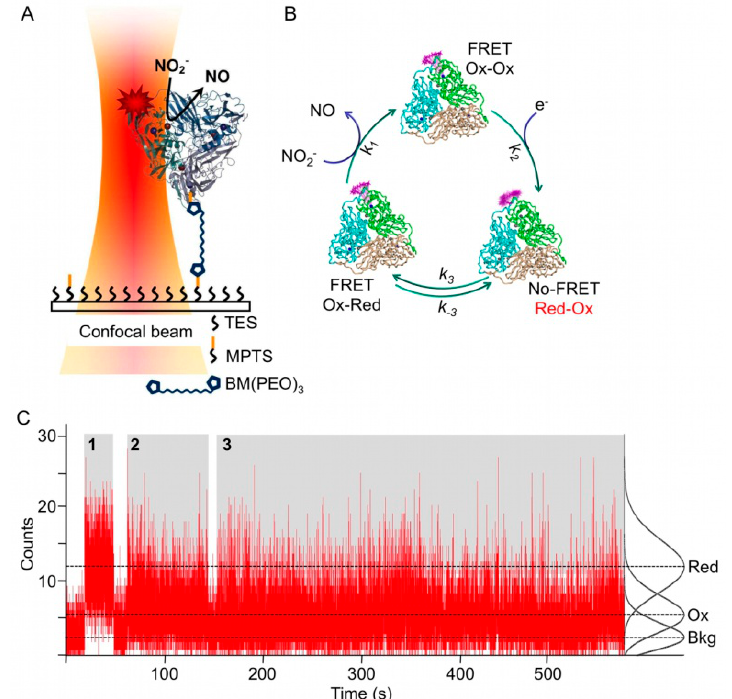
Figure 3. Single molecule experiments on Af-NiR-A655. ( A ) Enzyme immobilization scheme. Af-NiR-A655 is immobilized through a 1,11-bis-maleimidotriethyleneglycol (BM(PEO) ) linker to the glass cover slip modified with a 100:1 mixture of triethoxy 3 (TES) and mercaptopropyl trimethoxysilane (MPTS). The BM(PEO) linker was attached 3 to the protein via an exposed cysteine, introduced at position 93. The glass cover slip is covered with buffer to which nitrite plus a mixture of ascorbate/phenazine ethosulfate (PES) as sacrificial electron donor were added [28]; ( B ) Scheme of events during the turnover of labeled NiR. In the resting enzyme both T1 Cu and T2 Cu are oxidized (Ox-Ox) and dye fluorescence is partially quenched. Upon reduction of T1 Cu (Red-Ox) the dye fluorescence goes up as FRET to the reduced T1 Cu is not possible. When an electron is transferred from T1 to T2 Cu the label fluorescence is quenched again by the oxidized T1 Cu (Ox-Red). Nitrite binds to the reduced T2 Cu, is converted into nitric oxide and dissociates from the enzyme that goes back to the resting form; ( C ) Fluorescence time traces of individual Af-NiR-A655 molecules. The number of photons emitted during 10 ms intervals is recorded as function of time for three independent molecules during time blocks denoted by 1, 2 and 3 and colored in grey. The recording starts at the left of each time block and ends at the right with the bleaching of the molecule. Recording 1 represents a fully reduced inactive molecule while 2 and 3 represent turning over enzymes. The black curves at the right are the normalized Poissonian fits of the intensity distribution histograms and correspond with background (Bkg), oxidized (Ox) and reduced (Red) Af-NiR-A655. The dotted lines visualize the corresponding three different fluorescence